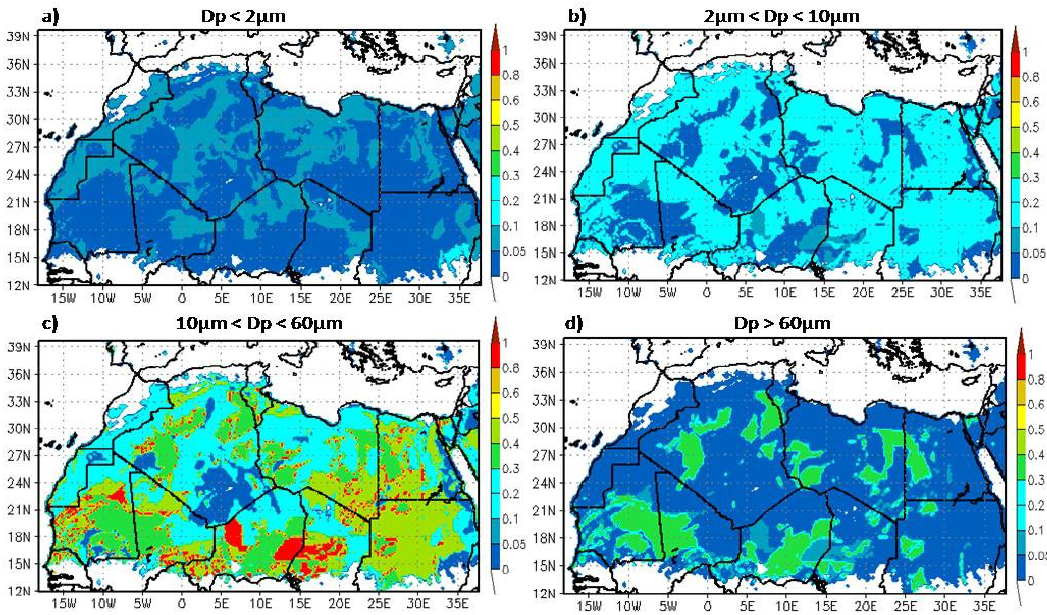
Fig. 4. The average relative surface area for each population of soil particles with diameter a) D p < 2µm, b) 2µm < D p < 10µm, c) 10µm < D p < 60µm, and d) D p > 60µm.